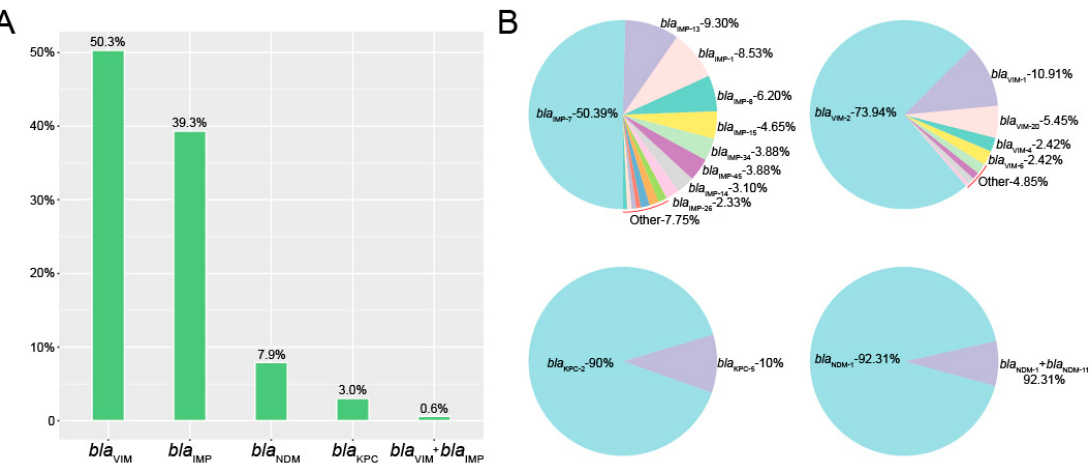
Figure 1. Identification of carbapenemase-producing P. aeruginosa isolates. ( A ) The numbers of carbapenem resistance genes in P. aeruginosa isolates. ( B ) The rates and numbers of variants in carbapenem resistance genes.